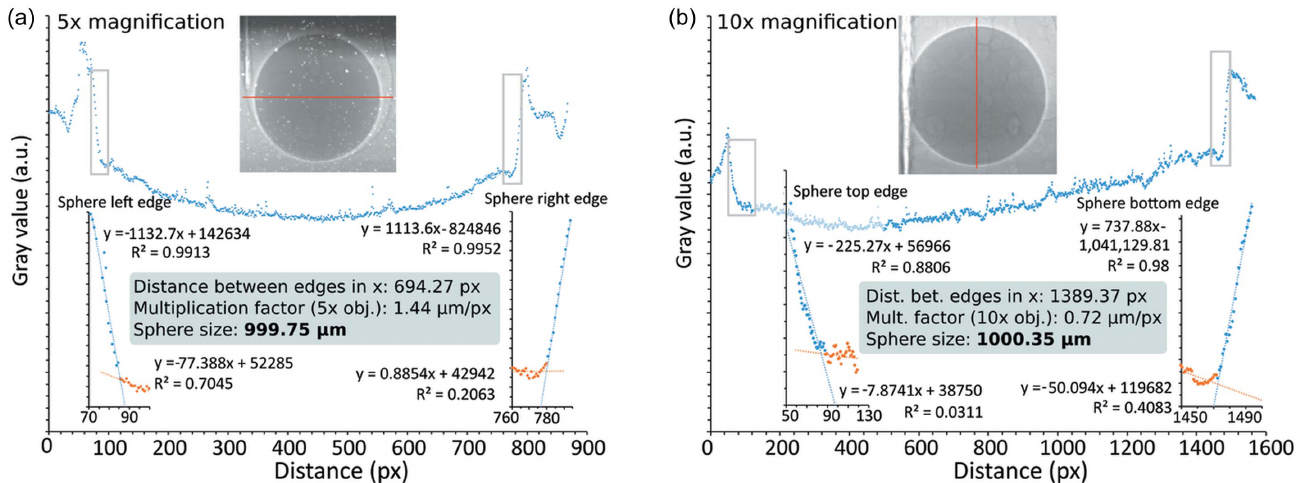
Figure 10 Radiographic imaging using the ( a ) 5 (cid:2) and ( b ) 10 (cid:2) microscope objectives on an extremely round metal sphere embedded in epoxy and evaluation of its diameter. The ‘bubbles’ visible in the images (particularly with 10 (cid:2) magnification) are air pockets in the epoxy tube. The red line in both images indicates the line profile used in the software Fiji (Schindelin et al. , 2012). Selected profile data points were used to fit linear functions, and the intercepts of the two functions at each end were adopted as the edges of the sphere. The distance between these two end points was calculated to obtain the sphere diameter for both 5 (cid:2) and 10 (cid:2) magnification, as